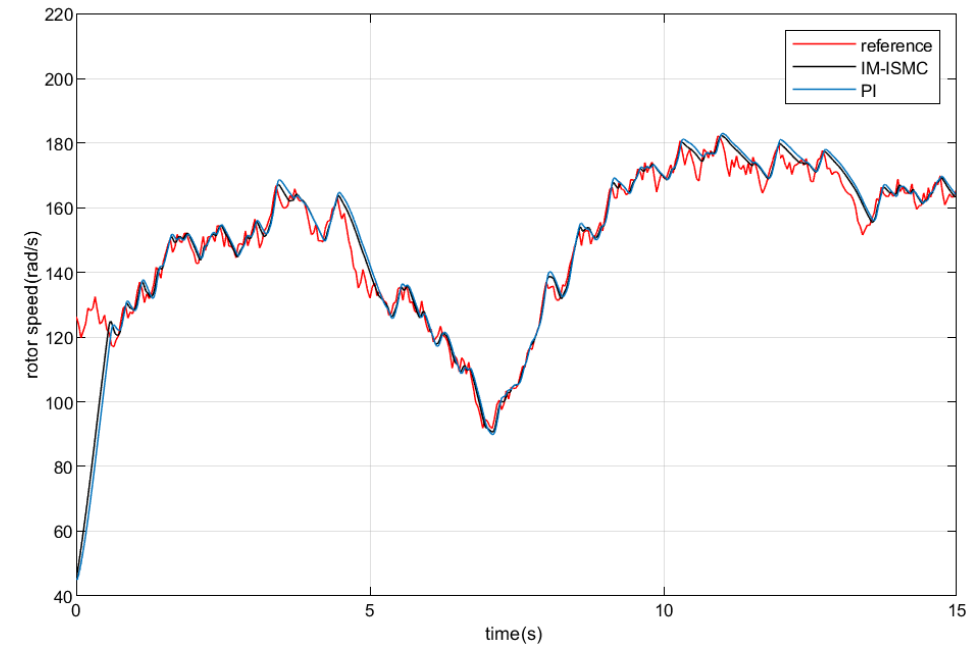
Figure 13. Simulation results of rotor speed.